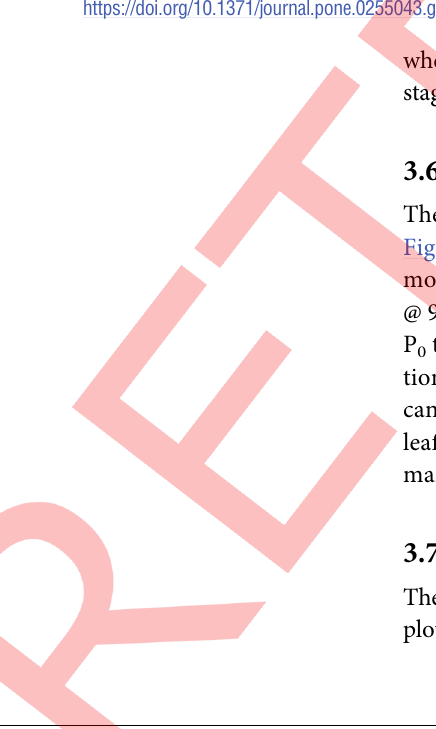
Fig 2. Effect of various organic and inorganic amendments on applied fertilizer P use efficiency.